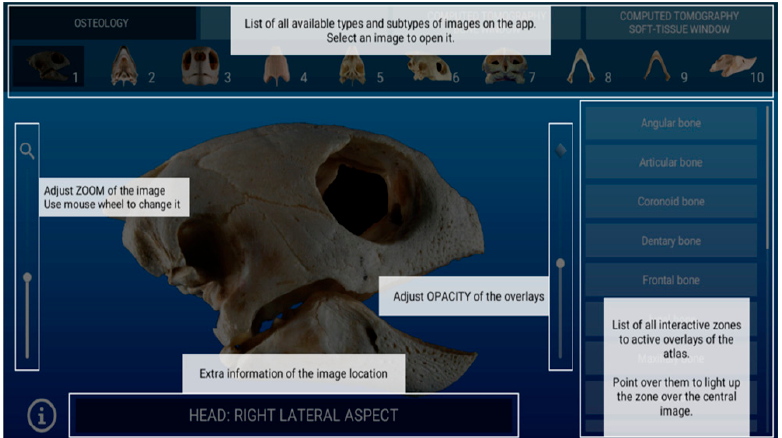
Figure 4. The extra functions of the image viewer are shown